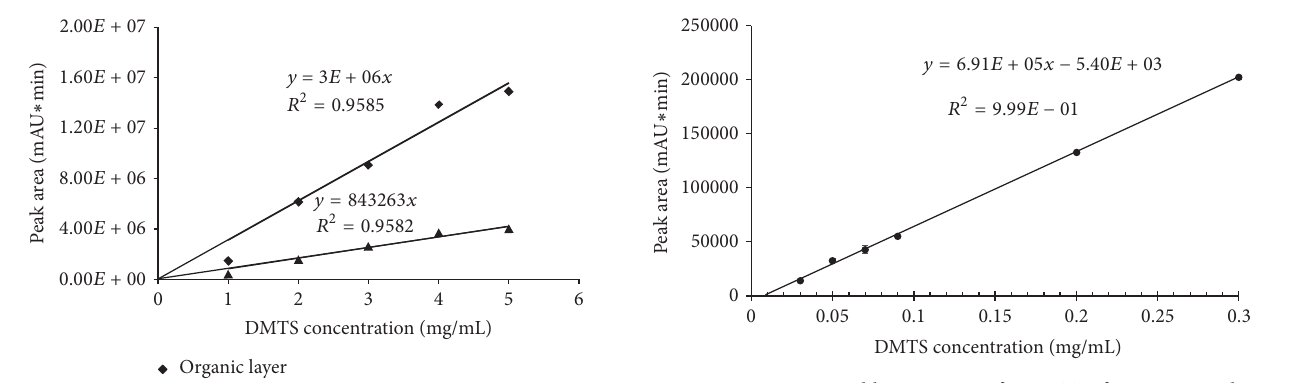
Figure 3: HPLC-UV calibration curve for DMTS after extraction by cyclohexanone from blood. Results represent the mean ± SD; 𝑛 = 2